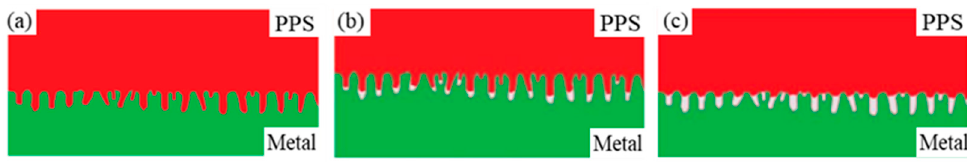
Figure 10. Schematic representation of three filling models. ( a ) completely filled; ( b ) partially filled; ( c ) unfilled.